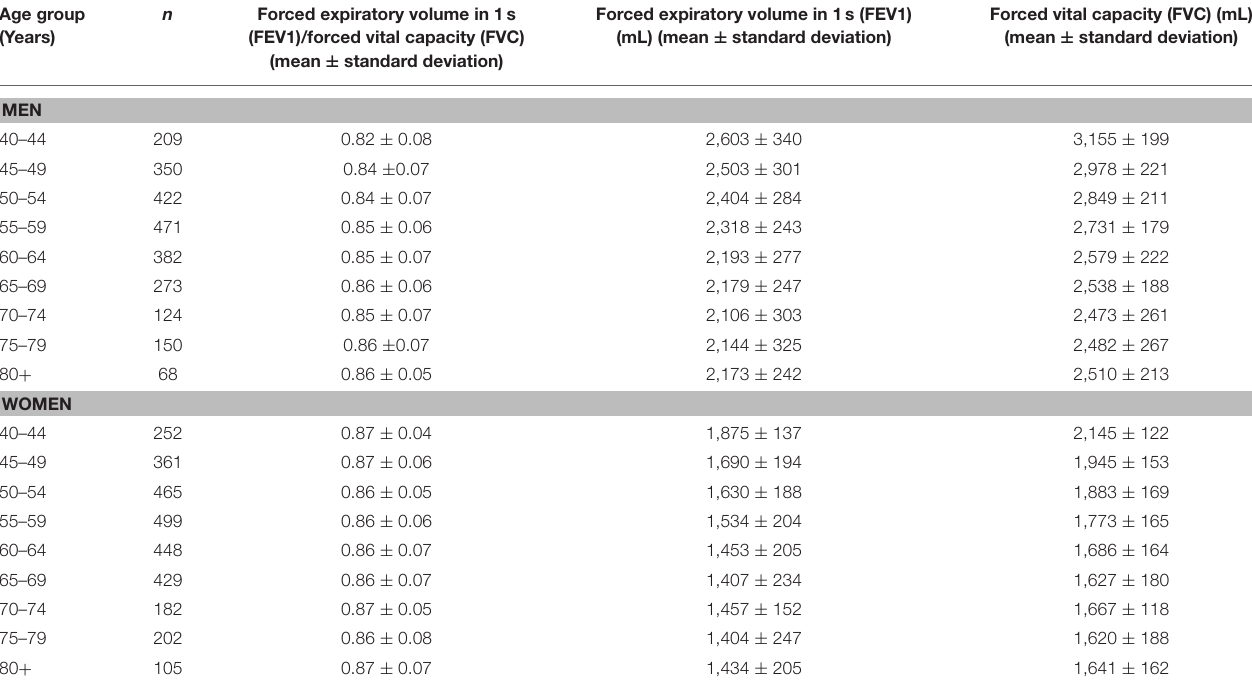
TABLE 2 | Spirometric measurements in the Ural Eye and Medical Study, stratified by sex, and age. Age group